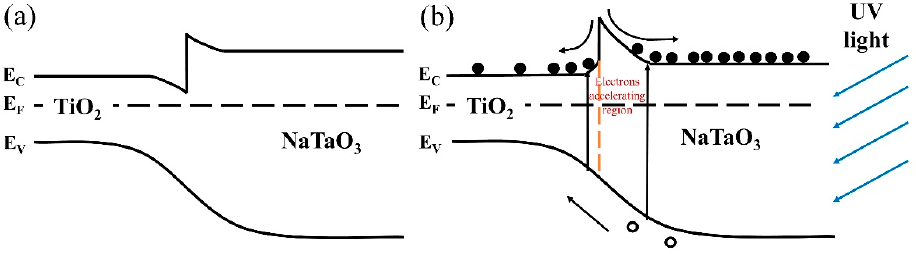
Figure 6. The energy band schematic diagrams of NaTaO 3 /TiO 2 : ( a ) in dark ( b ) under UV